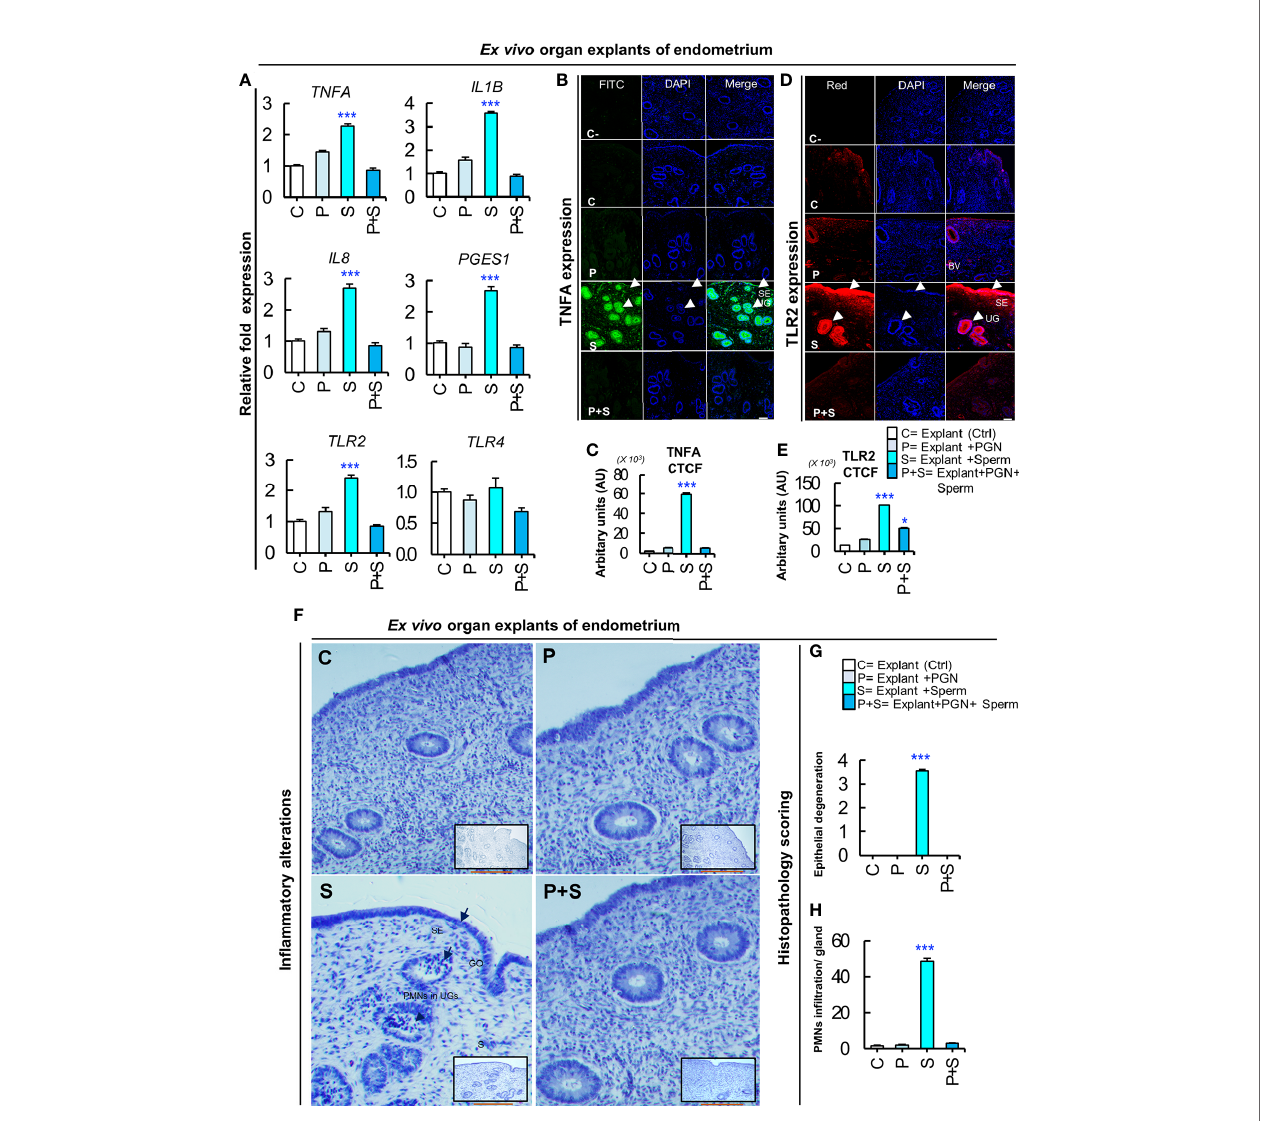
FIGURE 7 | PGN suppresses the sperm-triggered alterations in in fl ammatory genes and protein expression as well as histomorphology in ex vivo explants of endometrium. (A) Real-time PCR assay of the mRNA transcription levels of sperm-stimulated in fl ammatory genes after exposure to PGN. Fresh pre-ovulatory explants were exposed to PGN (10 pg ml − 1 ) for 3 h followed by co-culturing with sperm for 3 h. The mRNA expression of different in fl ammatory genes was assessed. Asterisk denote a signi fi cant variance (***P < 0.001) between the different groups when compared to the control group and data are presented as mean ± SEM. (B) Immuno fl uorescence assay of candidate in fl ammatory marker (TNFA) in ex vivo organ explants of endometrium. Immunostaining con fi rmed intense accumulation of TNFA (green) in UGs and surface epithelium (SE) (arrow heads) compared to stroma (S) in the “ S ” group and this was abrogated in the “ P+S ” group. (C) Semiquantitative scoring of corrected total cell fl uorescence (CTCF) of TNFA was based on mean fl uorescence intensity (MFI) and integrated density (IntDen) by ImageJ software expressed as arbitrary fl uorescence units (AU). DAPI was set as the nuclear counterstain (blue). Normal rabbit IgG replaced the primary antibody in the negative control (C-). (D) Immuno fl uorescence assay of the signaling marker (TLR2) in ex vivo organ explants of endometrium. Immunostaining con fi rmed intense accumulation of TLR2 (red) induced by sperm ( “ S ” group) speci fi cally in UGs and SE (arrow heads), compared to stroma (S) and compared to the C and other treated groups (P, and P+S). (E) Semiquantitative scoring of corrected total cell fl uorescence (CTCF) of TLR2 expressed as arbitrary fl uorescence units (AU). Fluorescence signal was captured using an all-in-one epi fl uorescence high-resolution imaging system (Keyence, BZ-X800, Osaka, Japan). BZ-X GFP (OP-87763), BZ-X RED (OP-87765), and BZ-X DAPI (OP-87762) fi lters were set for green, red and blue wavelengths, respectively. Random images from 3 independent experiments (using 3 different healthy pre-ovulatory uteri from 3 different animals) were evaluated and readings were statistically analyzed where asterisks denote a signi fi cant variance (*P < 0.05 , and ***P < 0.001) between the different groups when compared to the control group and data are presented as mean ± SEM. Magni fi cation: 200×. Scale bar=50 m m. (F) Representative photomicrographs showing delicate in fl ammatory reaction triggered by sperm in “ S ” group